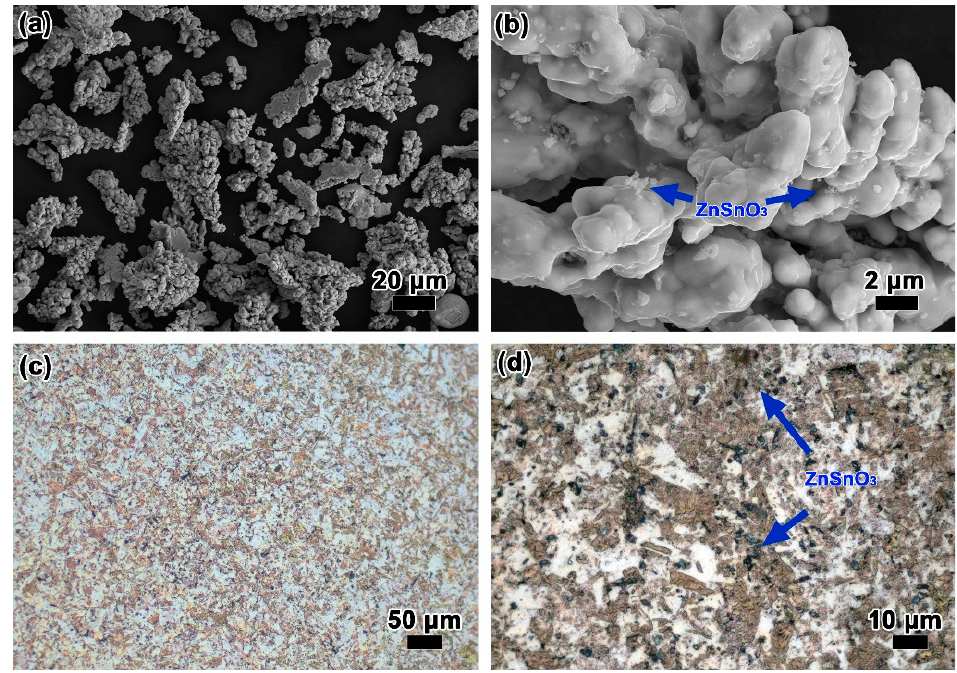
Figure 2. ( a , b ) The morphology of the mixed powders. ( c , d ) Microscopic structure of the ZnSnO 3 /Cu